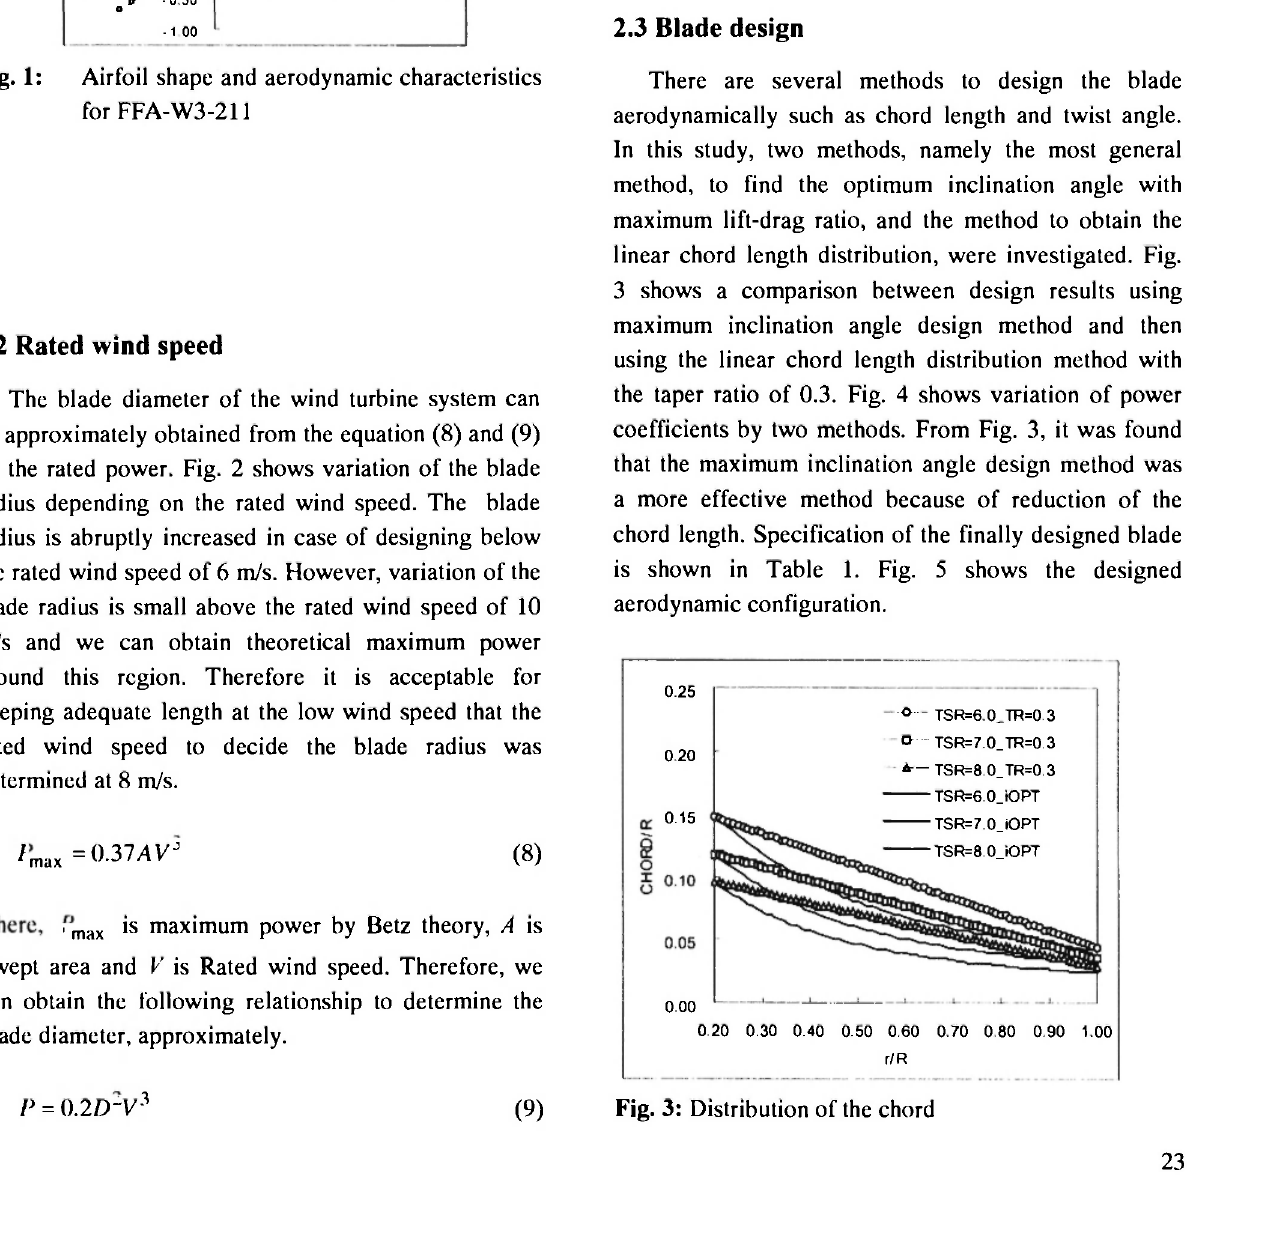
Fig. 2: Rated wind speed vs. blade radius